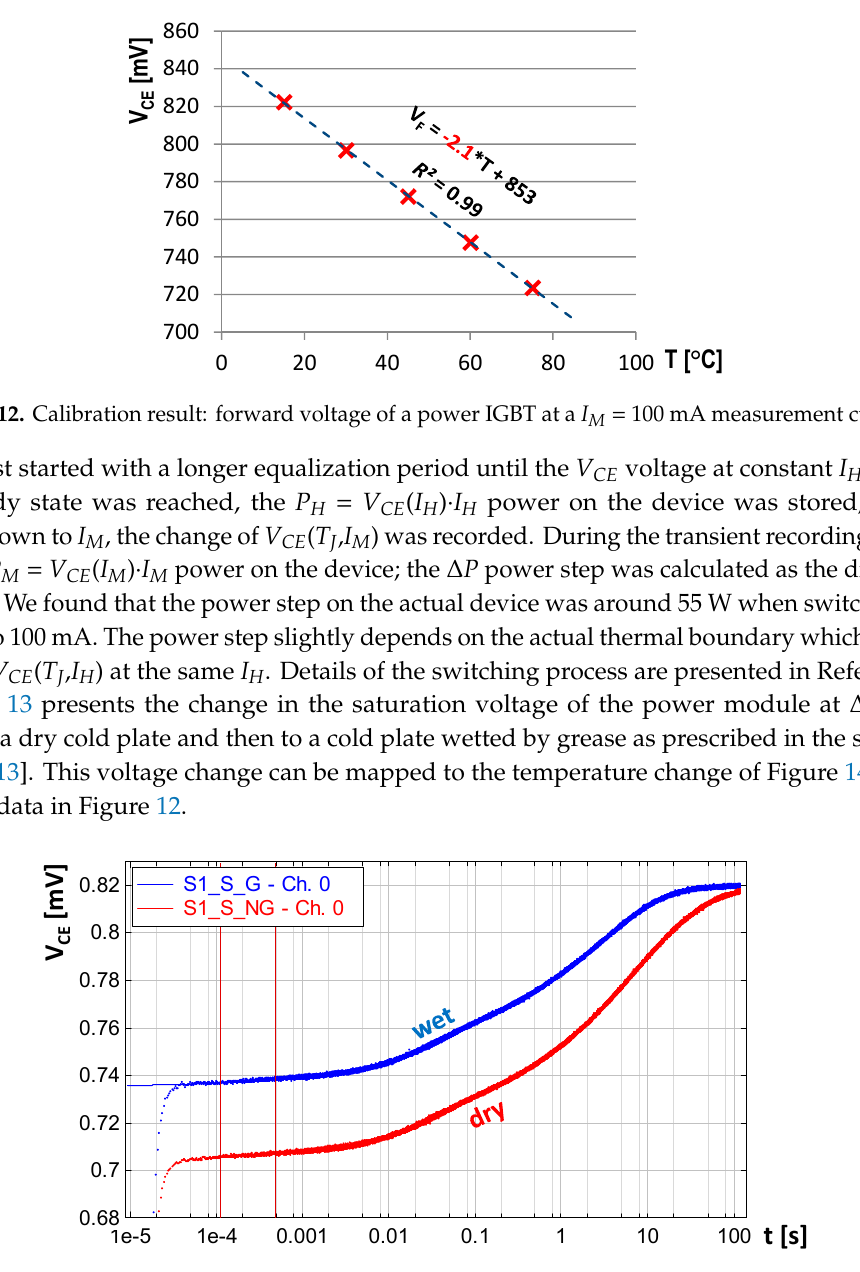
Figure 14. The recorded voltage transient converted to temperature change using the mapping of Figure 12. Figure 15. Z th curves calculated from Figure 14 The Z th curves (Figure 15) can be converted to structure functions, as shown in Section 3, and all considerations treated there apply again.